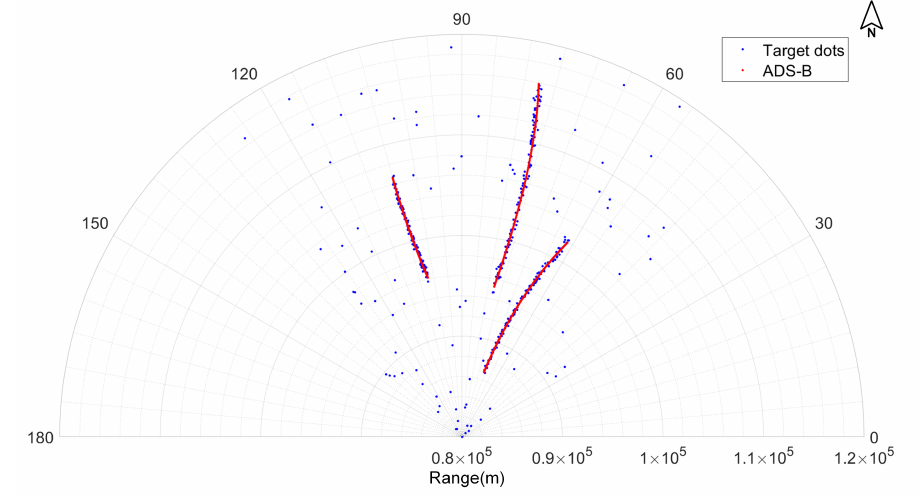
Figure 19. Result of target positioning and Automatic Dependent Surveillance-Broadcast (ADS-B)